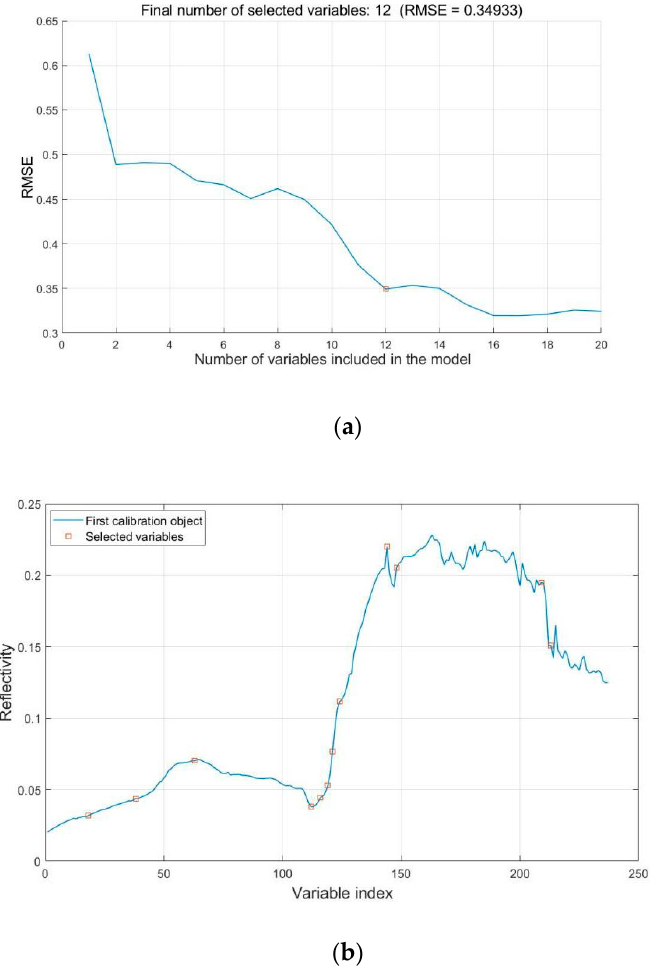
Figure 6. Feature wavelength screening results of the SPA algorithm. ( a ) The characteristic wavelengths of the sample spectral data of the training set; ( b )The specific distribution of characteristic band.